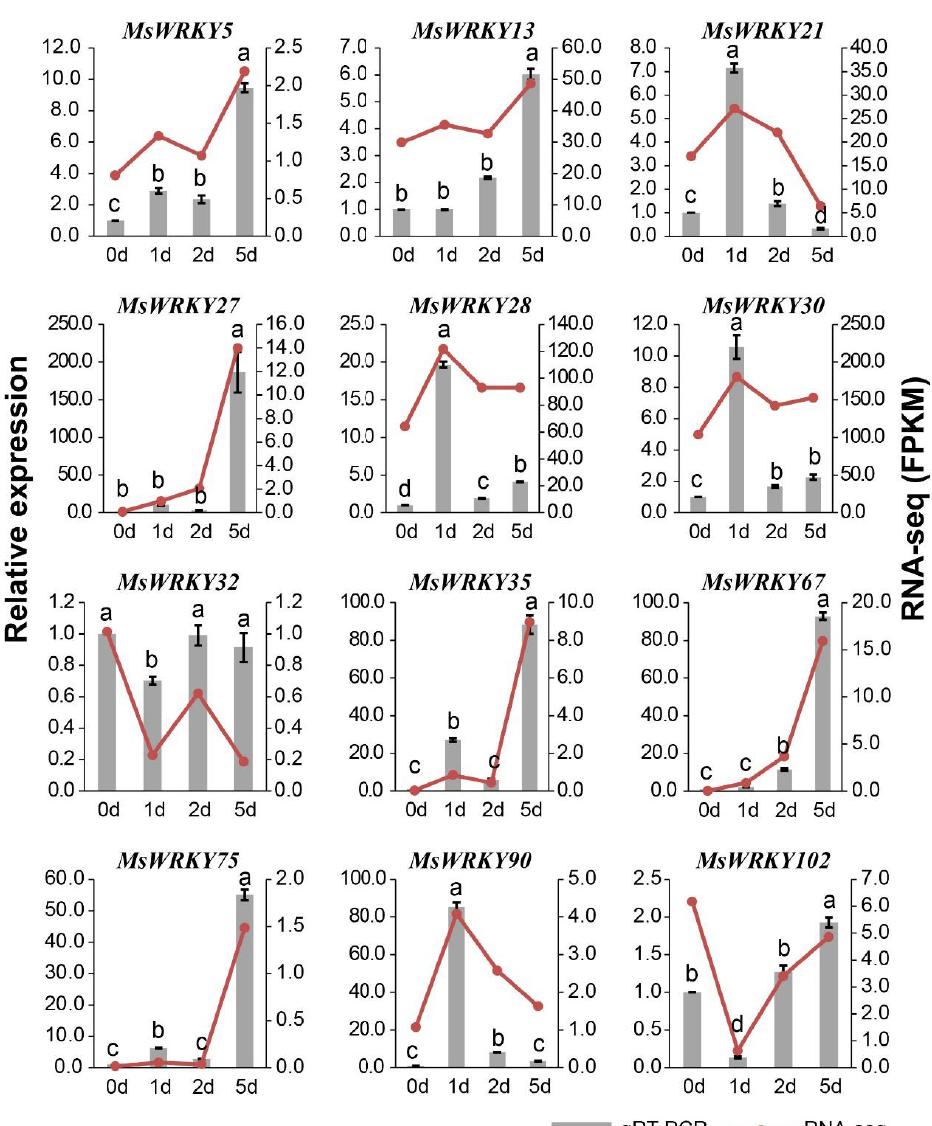
Figure 5. qRT-PCR verification of twelve selected MsWRKY DEGs during the infection of V. mali . Comparison of RNA-seq data (blue line) with qRT-PCR data (green column). The FPKM values from the RNA-seq were showed on the right y-axis. The relative expression levels were showed on the left y-axis. MsEF1-α was used as an internal reference gene. Each sample contained three biological replicates and each biological replicate contained three technical replicates. The relative expression data were analyzed by one-way ANOVA method, Tukey’s HSD test. Lowercase letters represented significant differences ( p < 0.05).